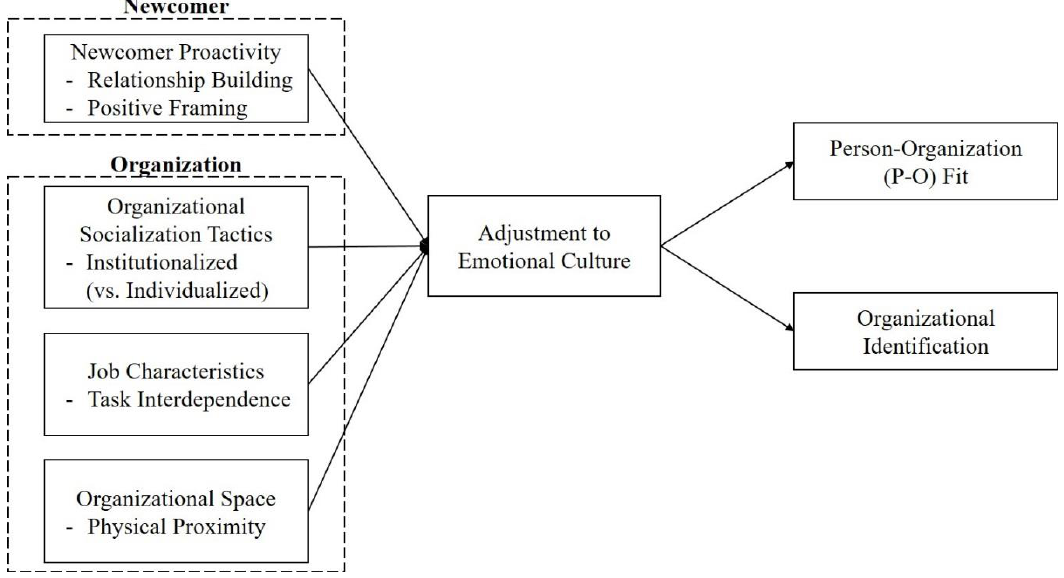
Figure 1. Emotional model of organizational socialization.